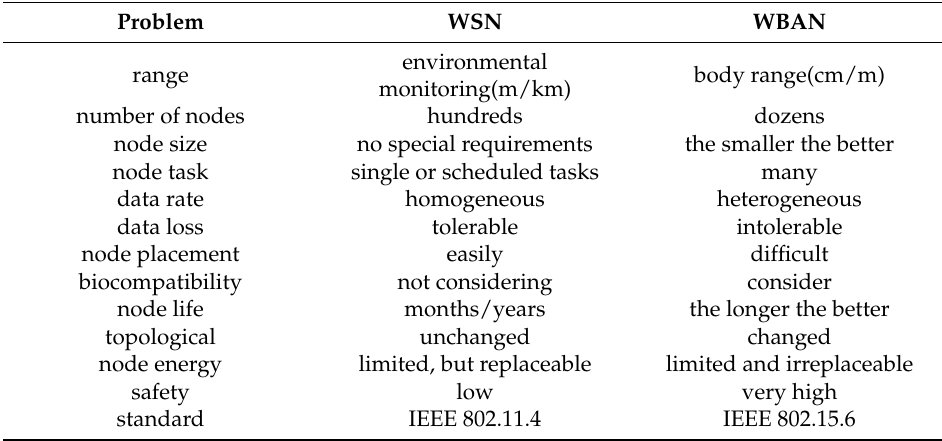
Table 1. Comparison between WSN and WBAN.